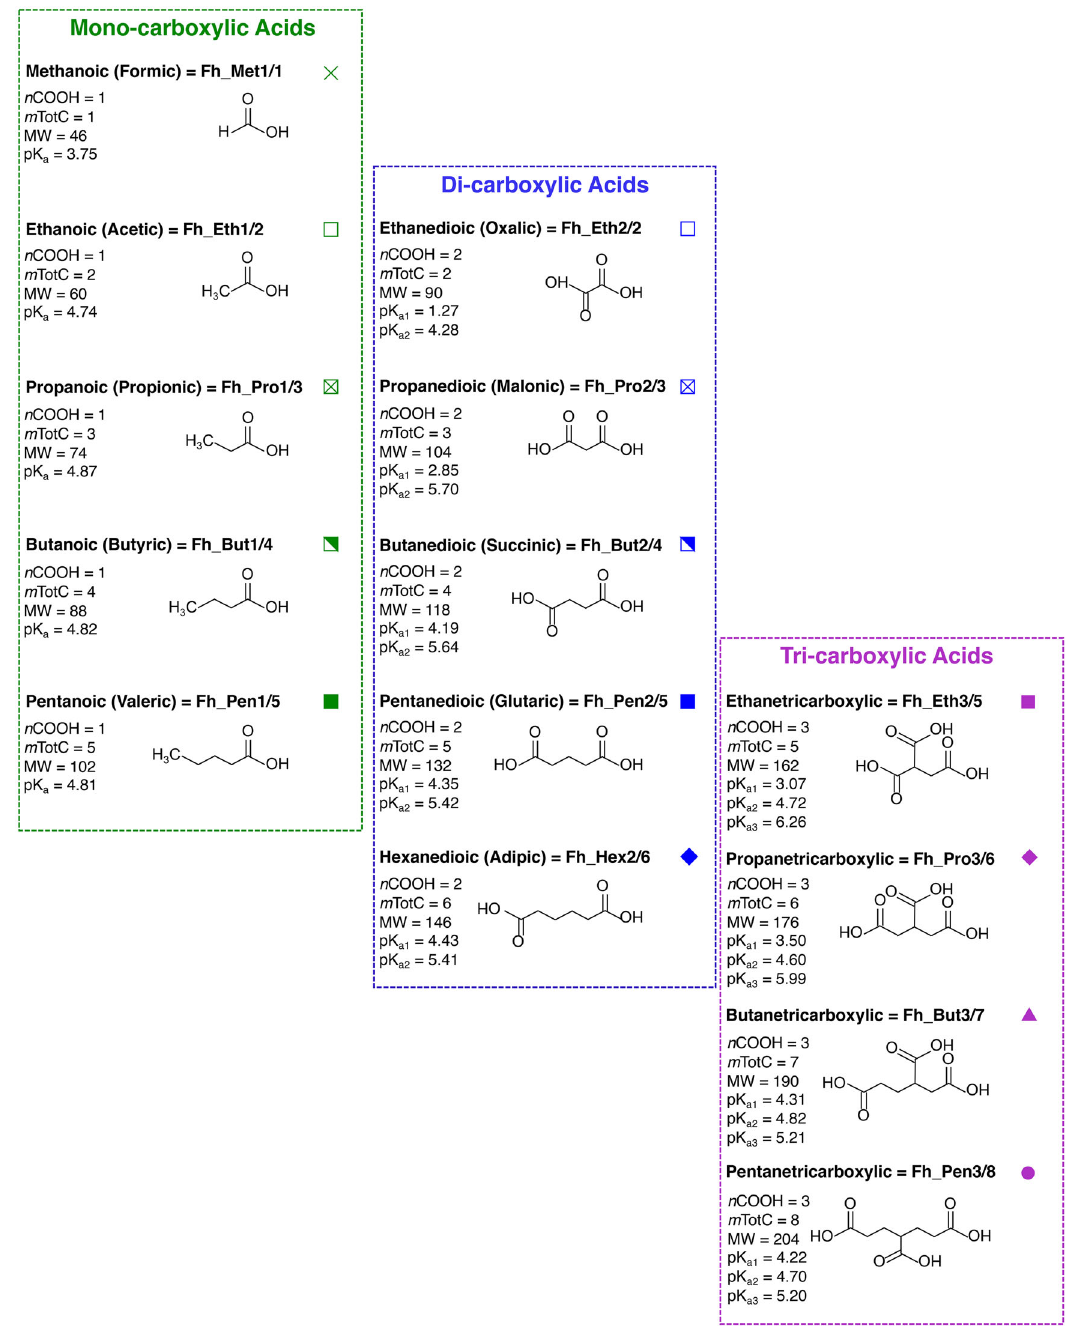
Fig. 1 Schematic showing mono-, di- and tri-carboxylic acids coprecipitated with iron (oxyhydr)oxide ferrihydrite. Mono-, di- and tri-carboxylic acids, including systematic IUPAC name, common name for reference in parentheses, coprecipitate nomenclature and coprecipitate data symbol; number of carboxyl functional groups ( n COOH); number of total carbon atoms ( m TotC); molecular weight (MW); and pK a of the carboxyl functional groups (available at Pubchem 85 or calculated using the ACD/Labs I-Lab 2.0 software (algorithm version: v12.1.0.50374)). For the coprecipitate nomenclature, coprecipitates are denoted Fh_acid n / m , where Fh is ferrihydrite, acid indicates the fi rst three letters of the systematic IUPAC name followed by n carboxyl groups and m total carbon atoms. Individual coprecipitates are denoted Fh_acid n / m _C:Fe where C:Fe is the molar C:Fe ratio of the solid phase. For the coprecipitate data symbol, coprecipitates are represented by a consistent data symbol, where colour indicates the number of carboxyl groups n (green, blue and purple = n 1, 2, 3 carboxyl groups, respectively), and shape indicates the number of total carbon atoms m (crosses, open squares, crossed open squares, half solid squares, solid squares, solid diamonds, solid triangles, solid circles = m 1, 2, 3, 4, 5, 6, 7, 8 total carbon atoms, respectively). In fl uence of the number of carboxyl groups n at constant number of total carbon atoms m on OC sequestration, stabilisation and persistence is investigated by comparing acids across the columns (sequentially increasing n ). In fl uence of the number of total carbon atoms m at constant number of carboxyl groups n on OC sequestration, stabilisation and persistence is investigated by comparing acids down the columns (sequentially increasing m ).